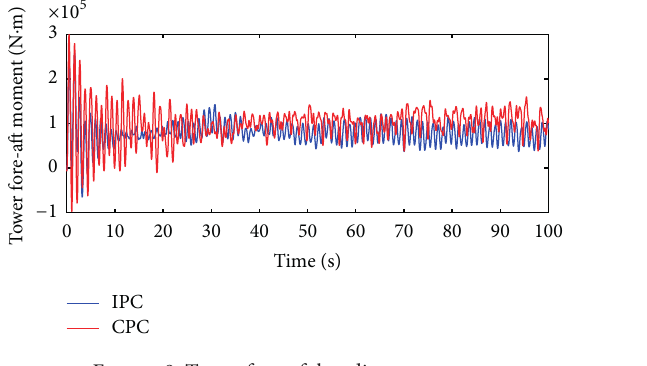
Figure 11: Flapwise moment.